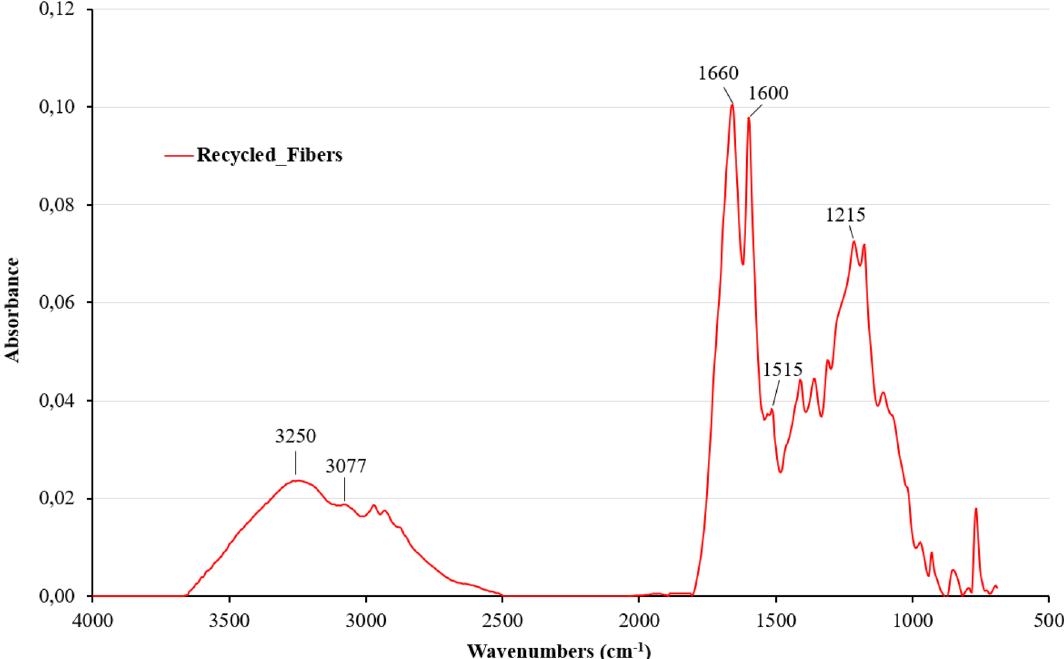
Figure 15. FTIR absorption spectrum of recycled carbon fibers. The absorption of virgin fibers is featureless. All absorption peaks are specific to the residual epoxy present on the surface of the recycled fibers.